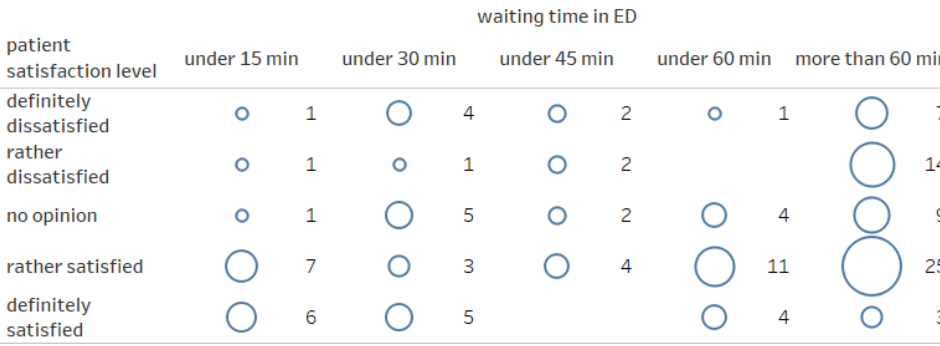
Figure 2 . Patient satisfaction depending on the waiting time in the ED